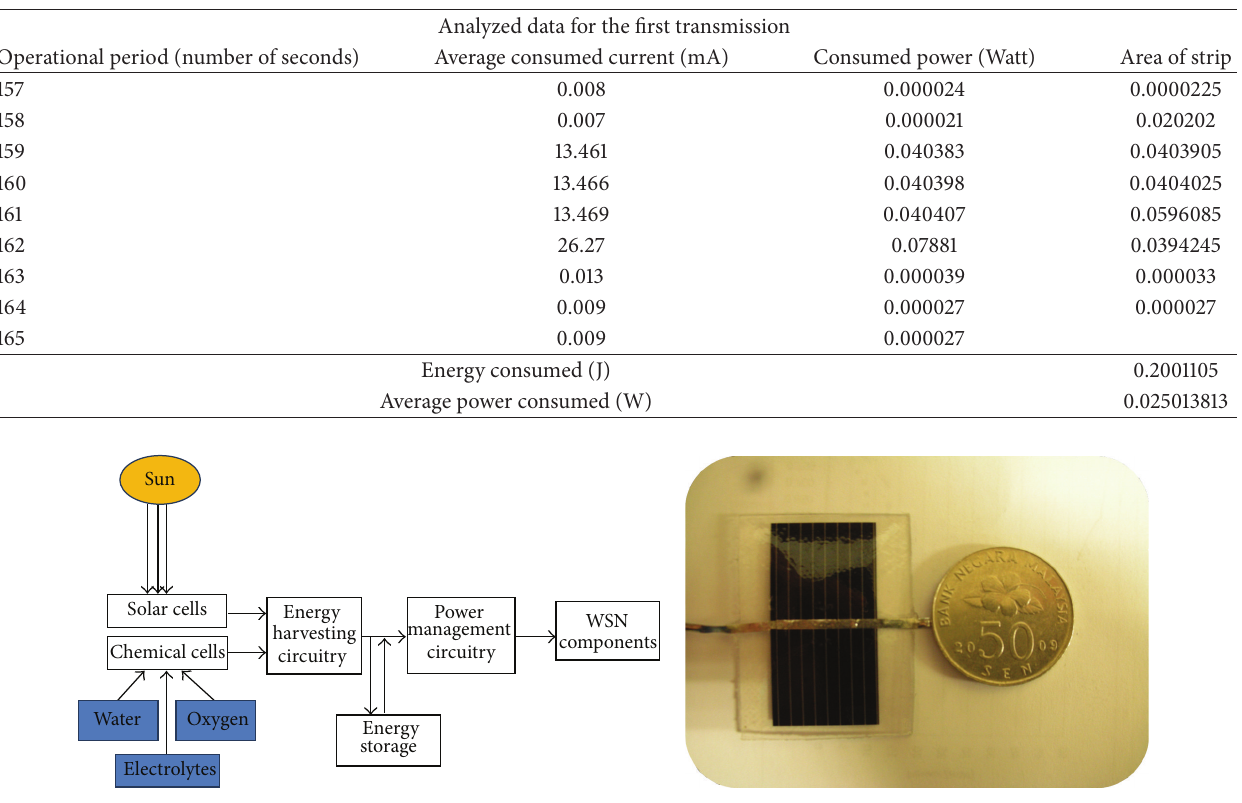
Table 2: Detailed energy consumption of WSN NODE for 1 transmission.